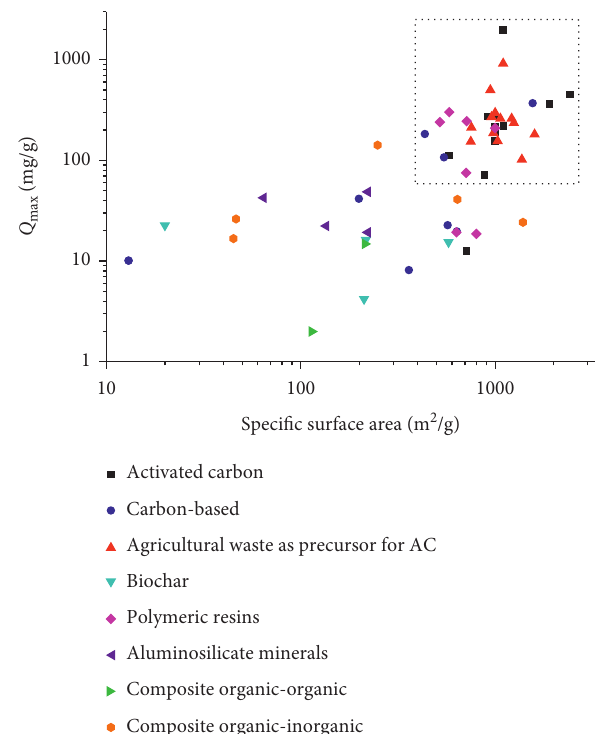
Figure 6: Relationship between the maximum adsorption capacity and specific surface area by adsorbent